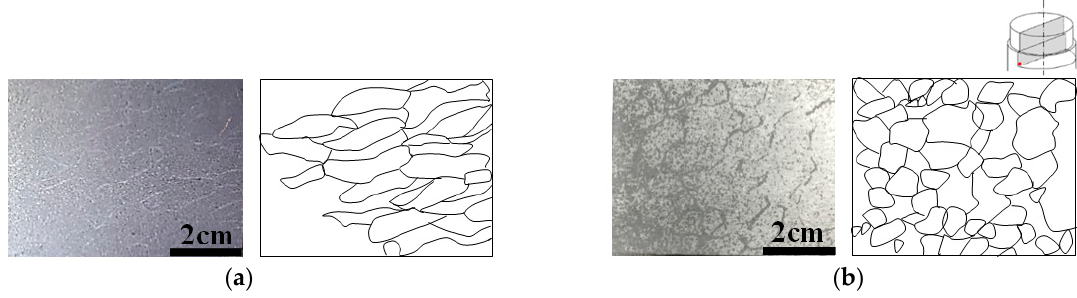
Figure 6. Grain morphologies in the bordering zones (the chill walls are on the left) of ( a ) LFR; ( b ) HFR.